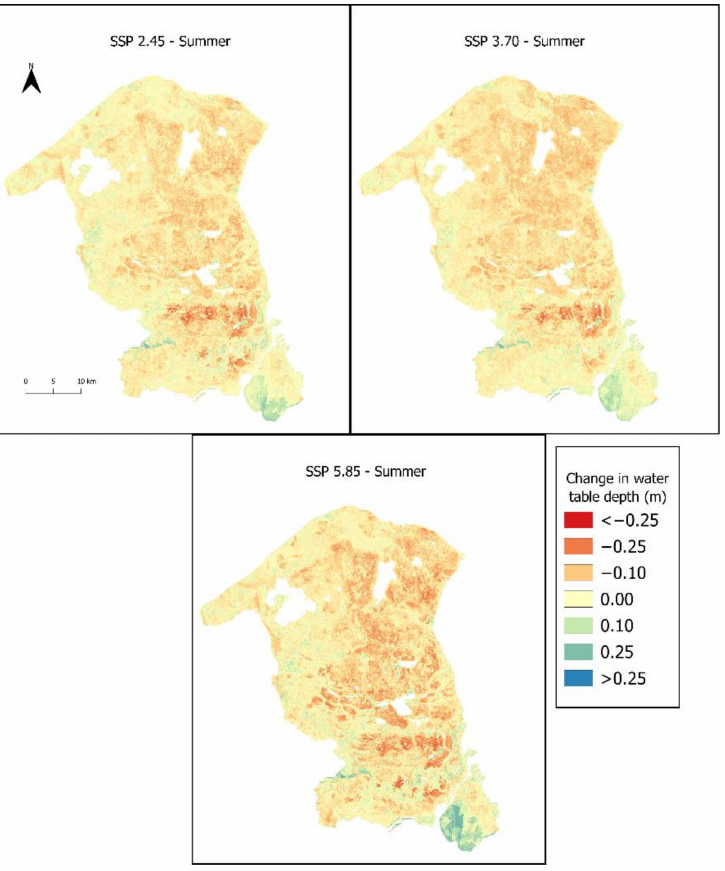
Figure 5. Differential maps showing changes in the water level between the present and each of the future SSPs selected, for the summer season. Positive numbers indicate a rise in the water table, while negative numbers indicate a fall.